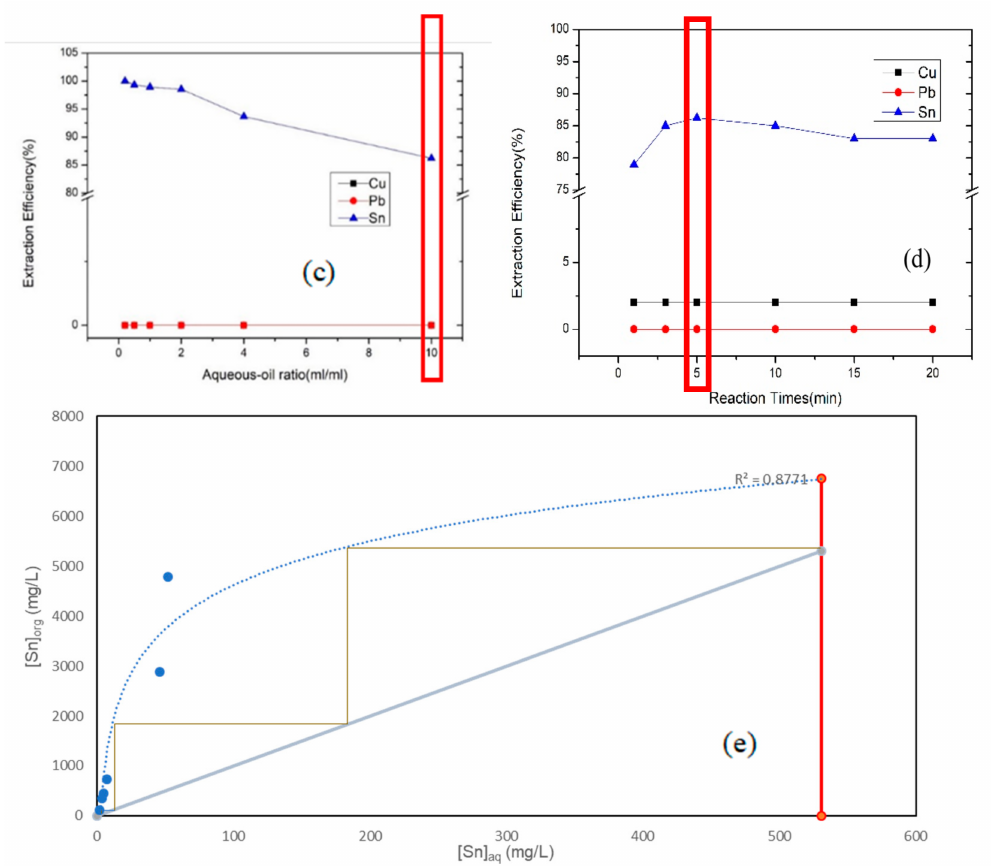
Figure 10. Effect of tin extraction efficiency on ( a ) pH value, ( b ) concentration of TBP, ( c ) A/O ratio, and ( d ) reaction times. ( e ) McCable–Thiele Diagram for stimulating the stage of extraction in AO ratio 10.